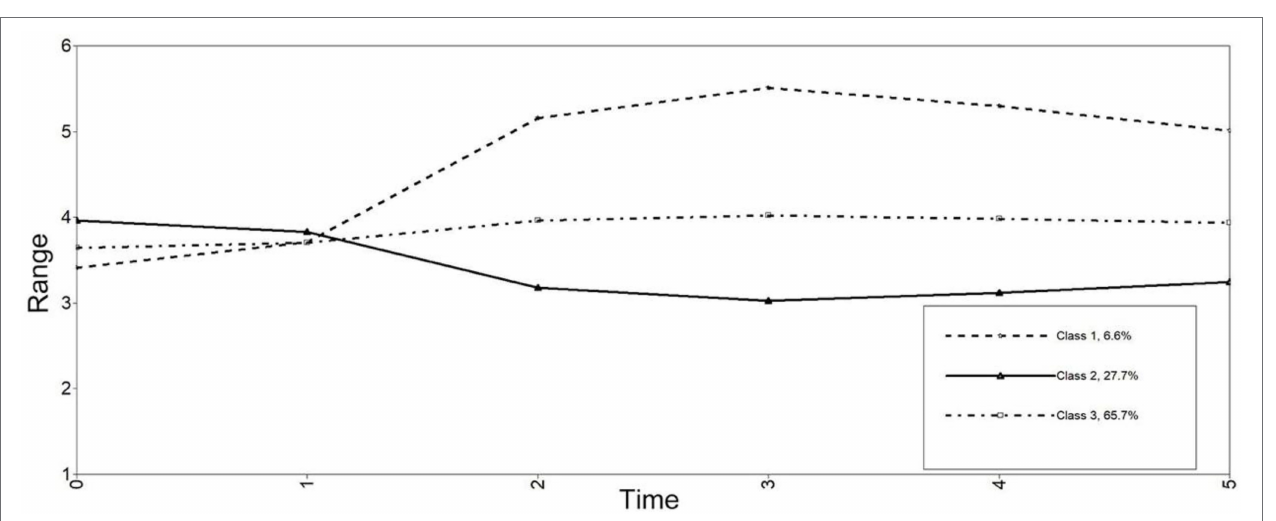
FIGURE 1 | Estimated longitudinal trajectories of motivation for